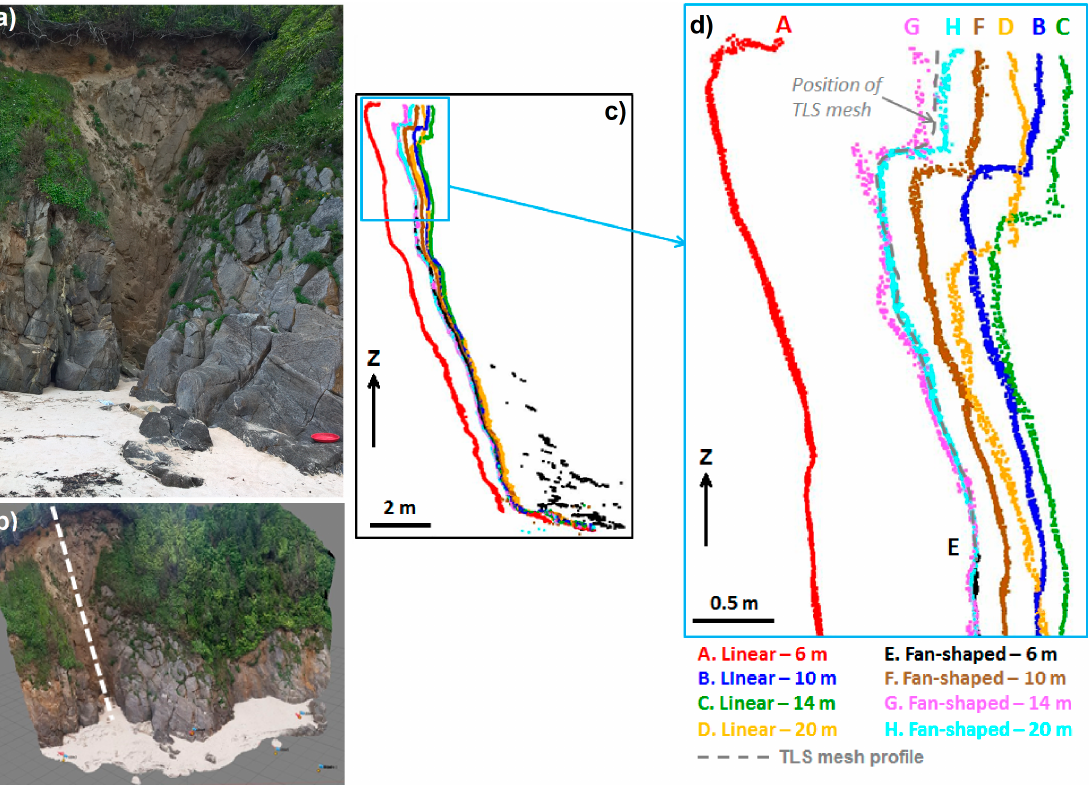
Figure 8. ( a ) Picture of the cliff face at the moment of the survey. ( b ) Position of the topographic profile on the SfM dense point cloud. ( c , d ) Comparison of shape and position of the profiles extracted from the SfM dense point cloud obtained for the different survey protocols.